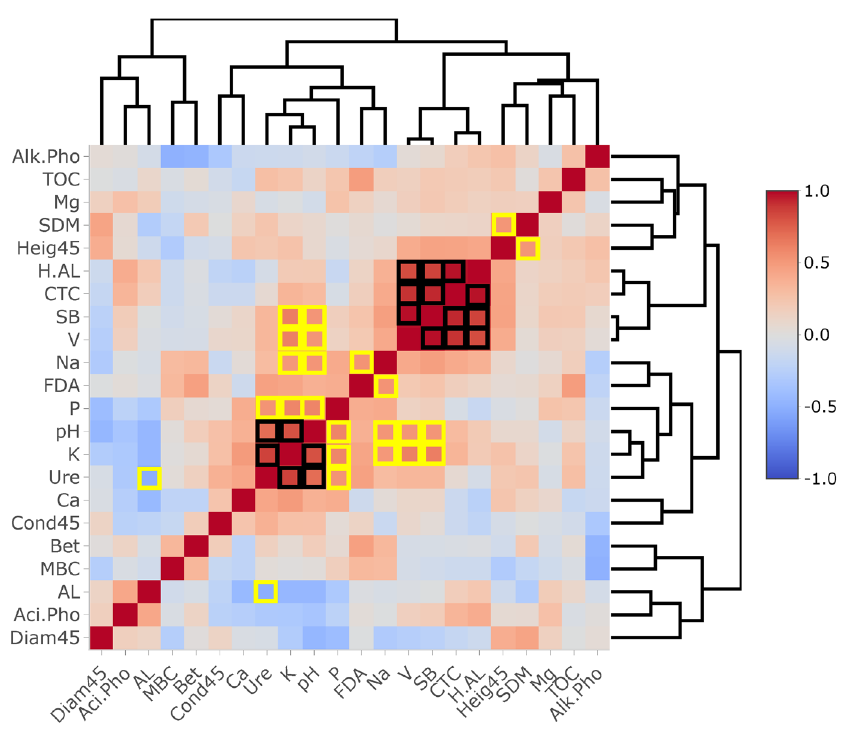
Figure 2. Heatmap with correlations of chemical, microbial and enzymatic soil attributes and initial growth of bean plants cultivated in sandy Entisol treated with coffee biochar in Northeastern Brazil. The polygons in the yellow and black colors represent significant correlations (ρ <0.05) higher than 0.5 and 0.70, respectively, according to Pearson’s product-moment correlation coefficient (r) following the